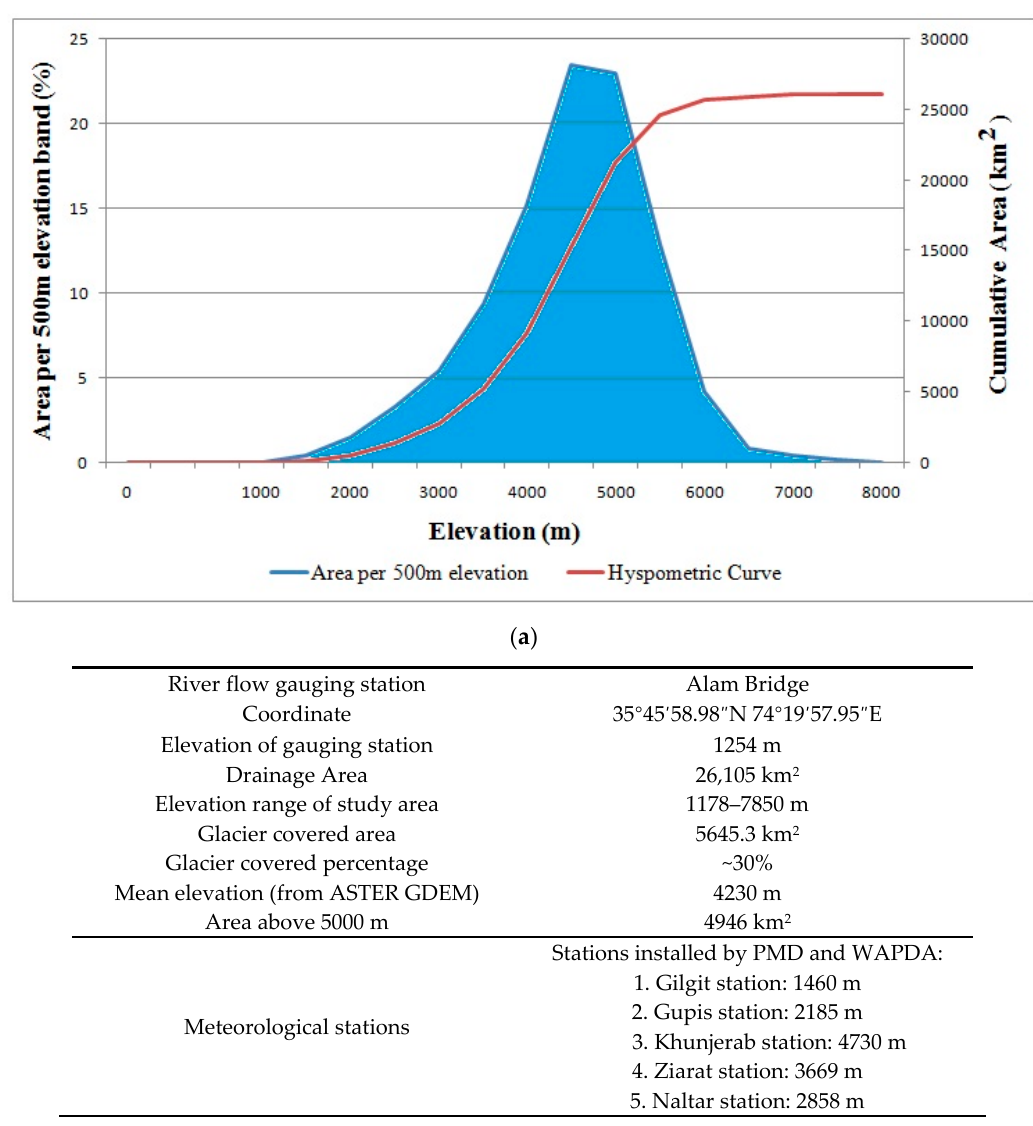
Figure 1. Study area in northern Pakistan.